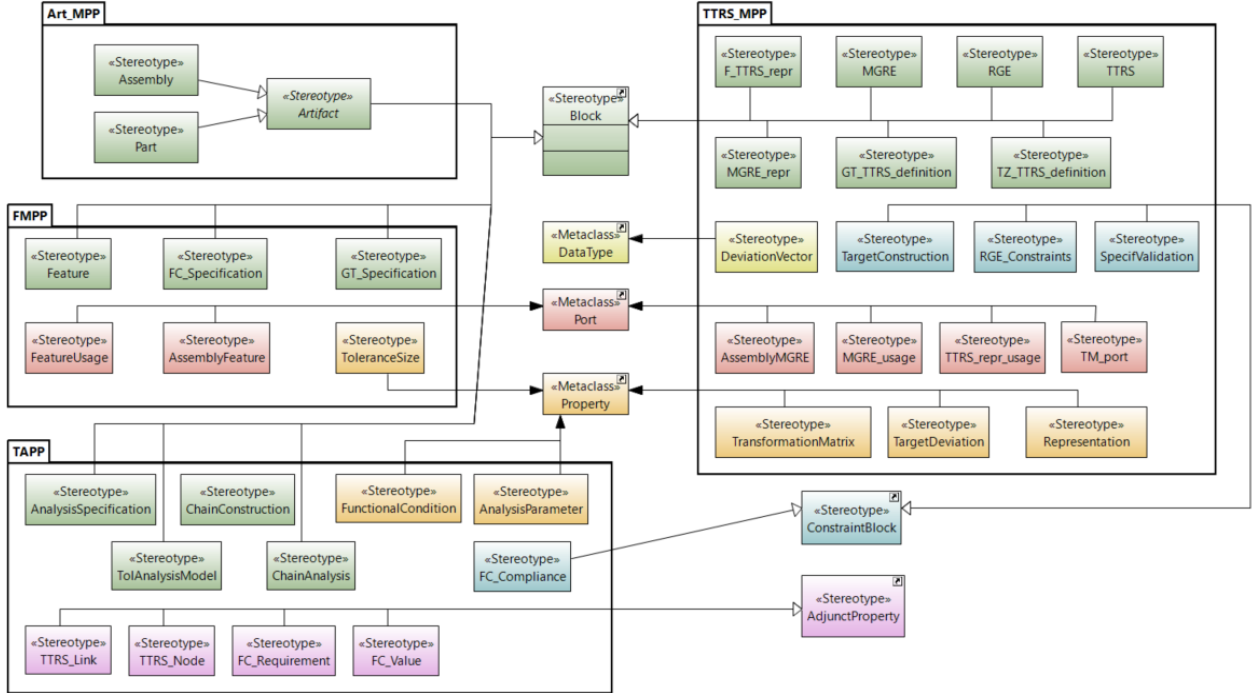
Figure 4. Package diagram with the stereotypes of the developed